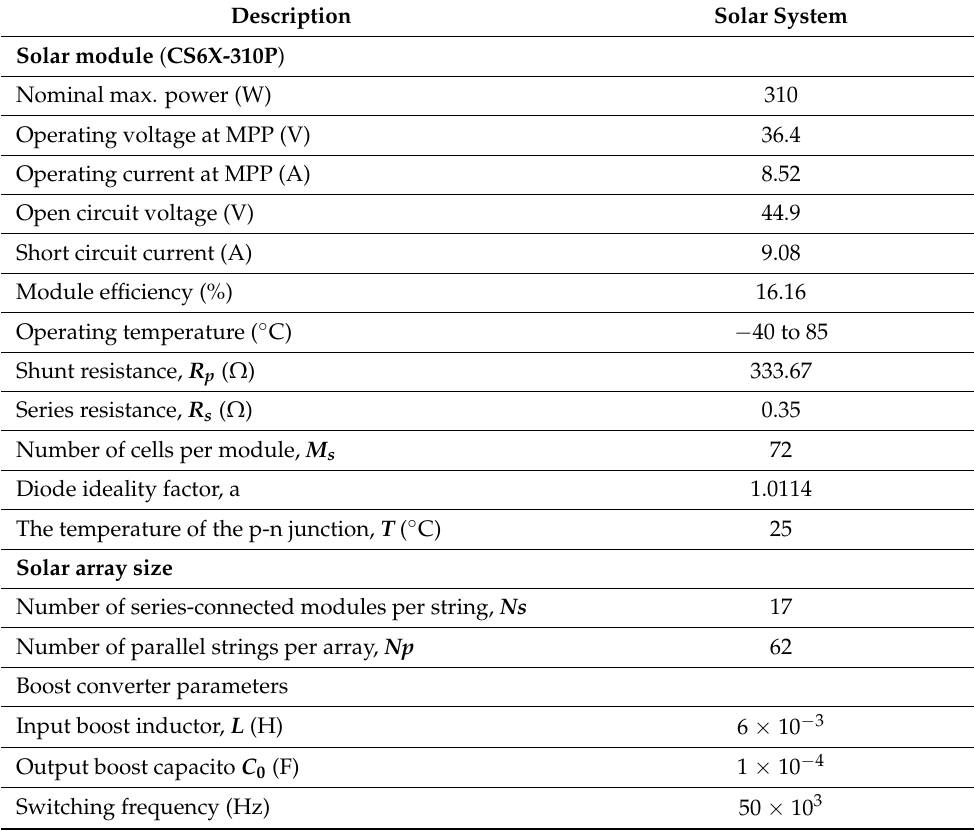
Table A2. Parameters list of a solar PV